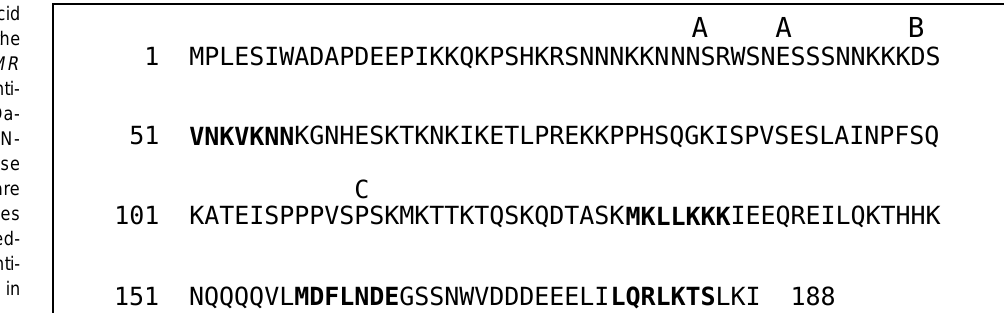
Figure 4 - Derived amino acid sequence corresponding to the coding region of gene YMR 255W. Sequence motifs identi- fied by the Yeast Proteome Da- tabase as putative targets for N- glycosylation (A), protein kinase A (B) or Cdc28 kinase (C) are underlined. Heptad sequences that represent potential coiled- coil structures have been identi- fied (24) and are displayed in bold